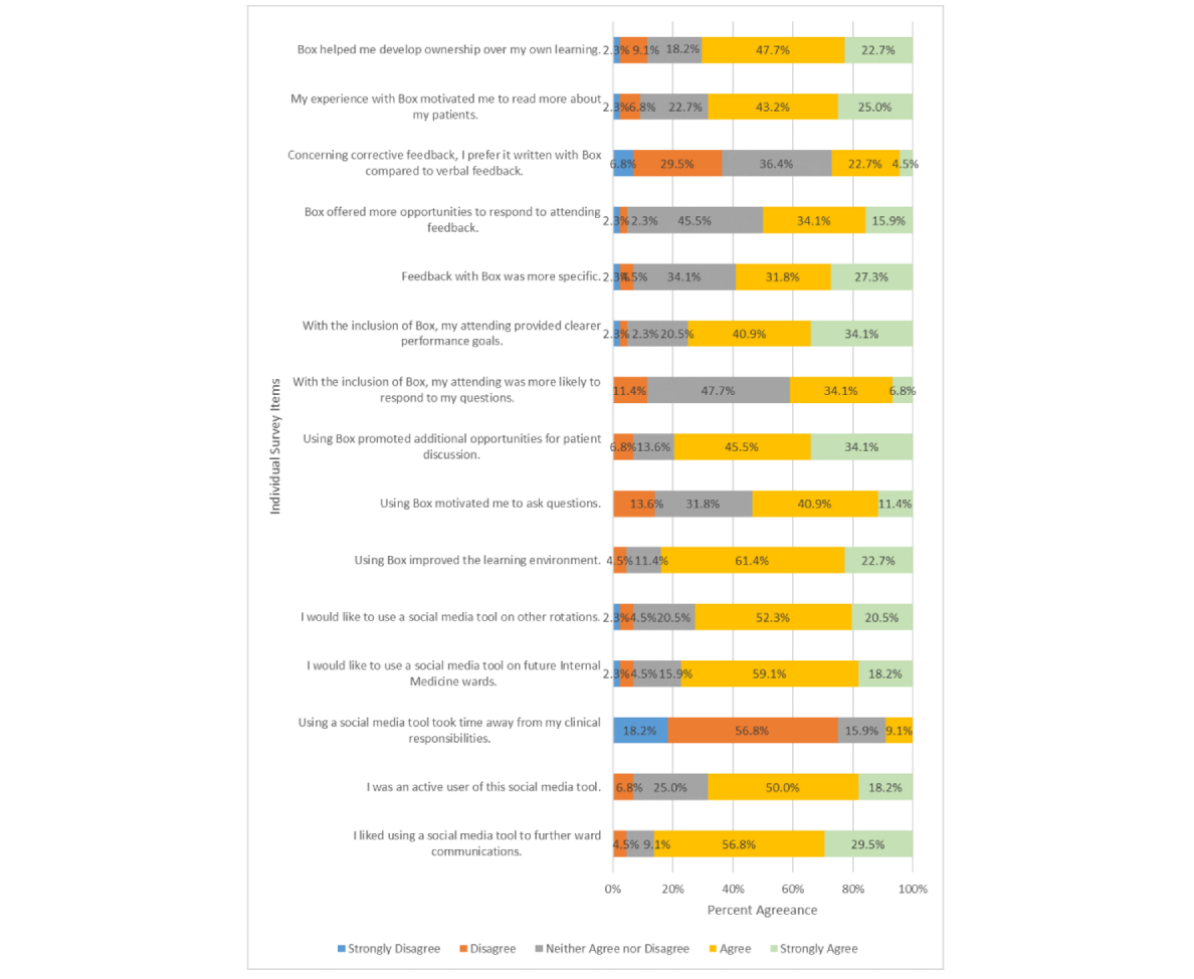
Figure 3. Postexperience survey tool